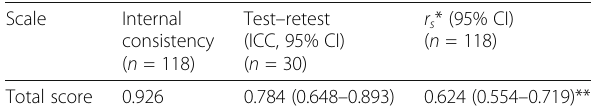
Table 2 Internal consistency, test – retest reliability and convergent validity of the SPQ